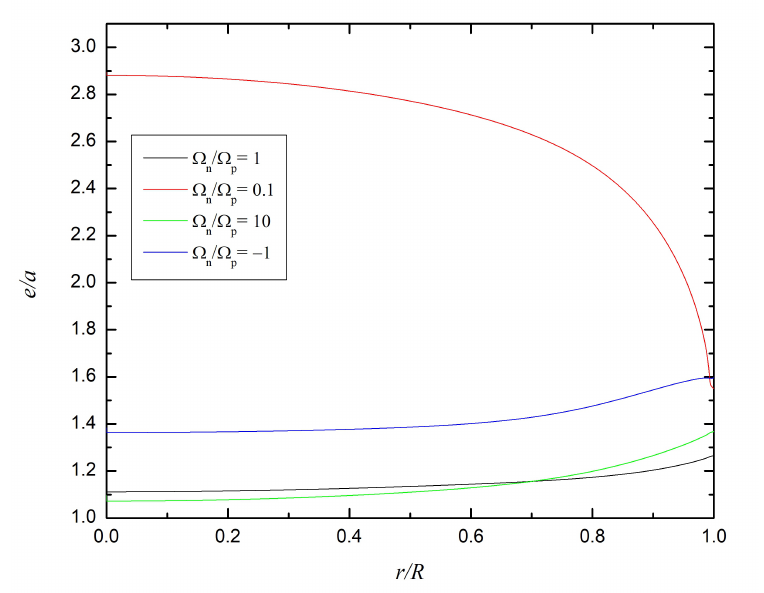
Figure 5. Profiles of the ellipticity e (normalized by the spin parameter a ) of constant energy-density surfaces for stellar models constructed from the NL3 EOS with ln ¯ λ tid = 5 and different values of Ω Ω n / p